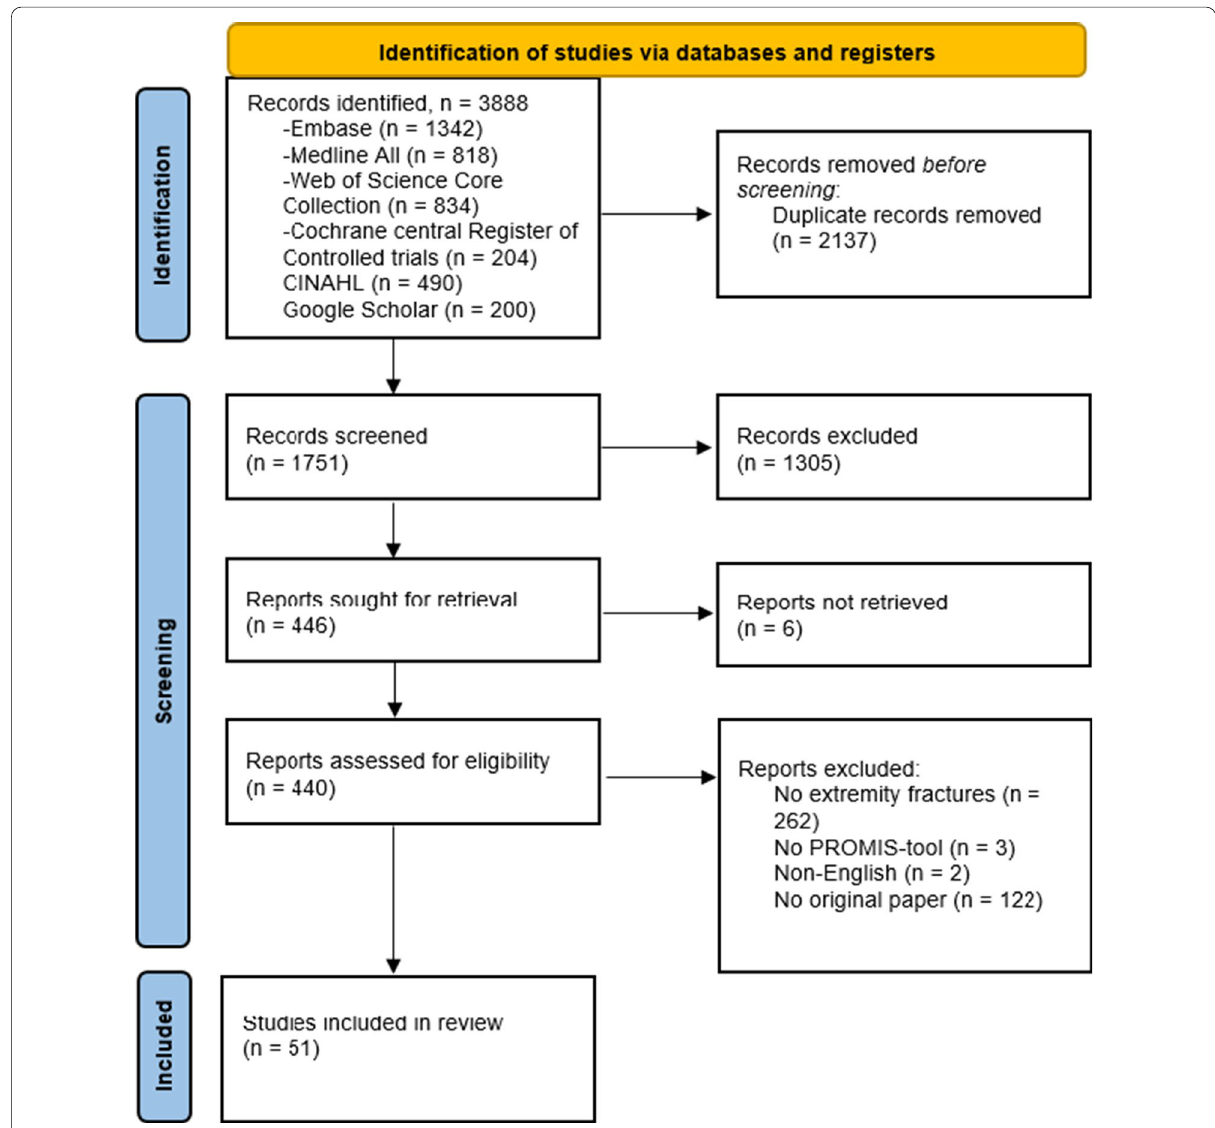
Fig.1 Flow diagram showing the process of identification, screening and inclusion of eligible